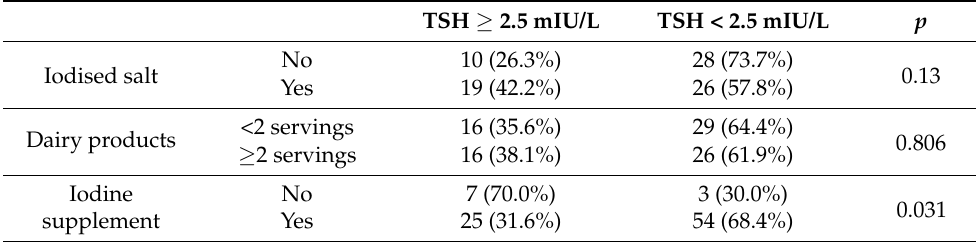
Table 3. Iodine consumption data and TSH values.